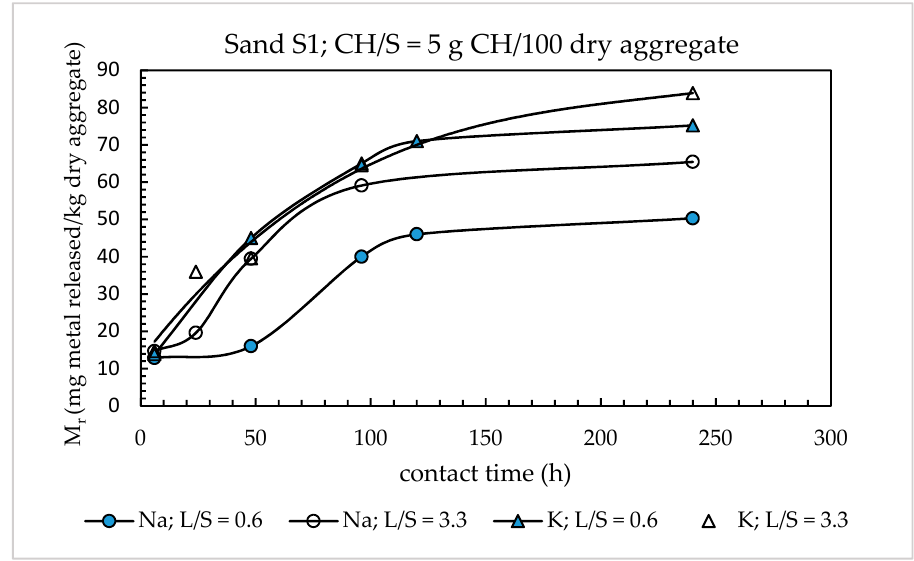
Figure 4. Effect of contact time on alkaline metal release from sand S1 at two different L/S ratios. As expected, at long contact times (120–240 h), the M r values obtained for both sodium and potassium with the two L/S ratios differed more significantly than the respective values determined at shorter contact times. At 240 h, an increase of the L/S ratio from 0.6 to 3.3 g leachant/g dry aggregate produced a percentage M r increase of 30% for sodium and 14% for potassium, against 15% for Na and 6% for K at t c = 6 h.